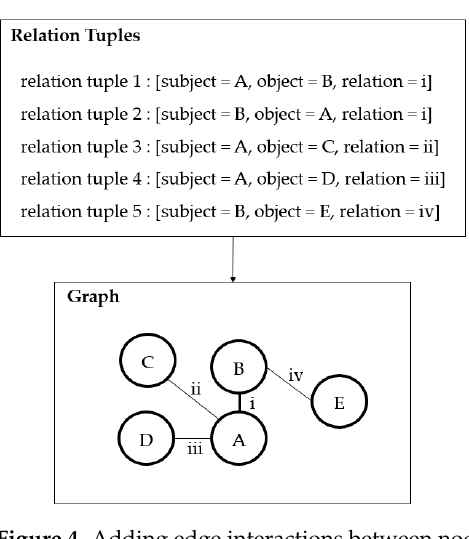
Figure 4. Adding edge interactions between nodes.